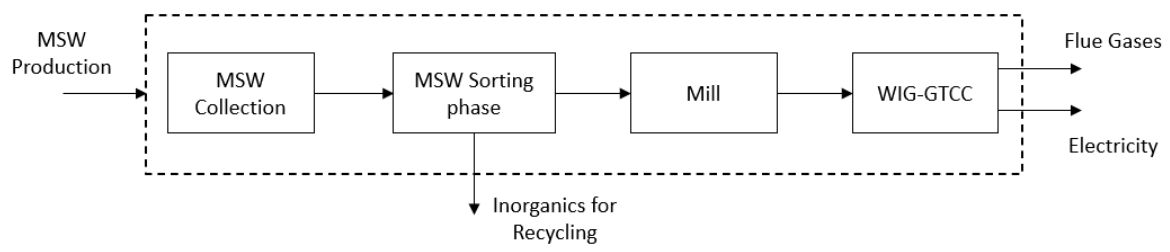
Figure 2. System Boundaries .